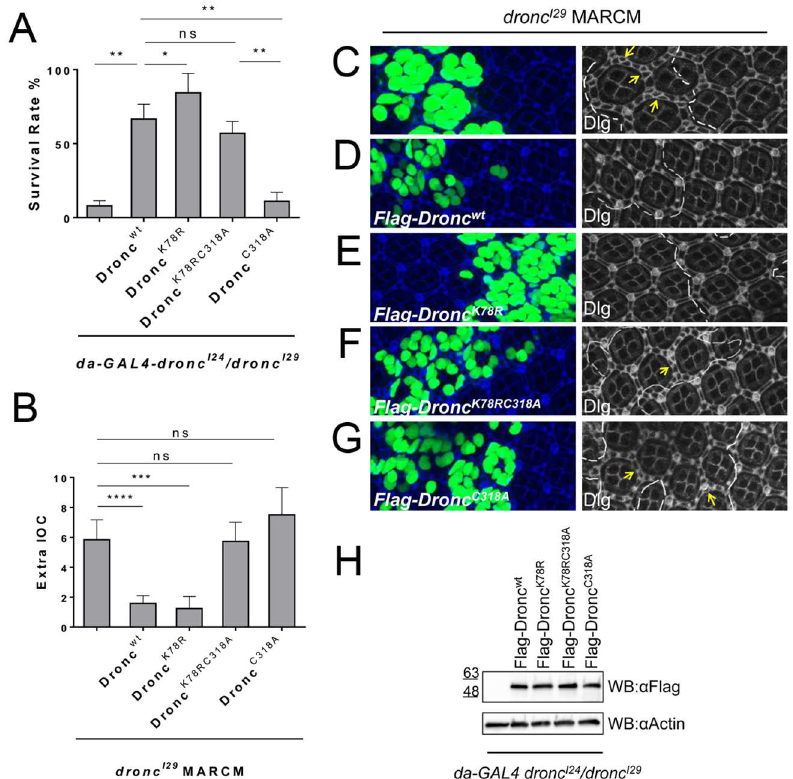
whereas da > Flag-Dronc C318A cannot. ( B ) Quantificationof the number of additional interommatidialcells (IOC) shown in (C-G). Genotypes are indicated. MARCM was used to express transgenic